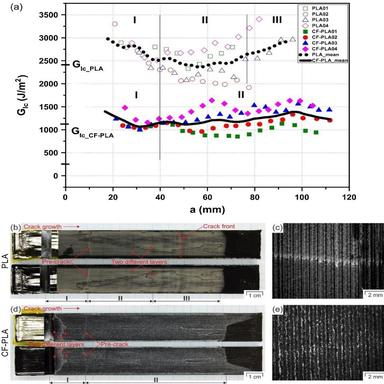
Crack resistance curves of tested DCB specimens of PLA and CF-PLA according to the modified beam theory (a) and fracture surfaces of the tested DCB specimens of PLA (b, c) and CF-PLA (d, e). To visualise the pre-crack, a representation of higher magnification is given in (c) for PLA and (e) for CF-PLA. In (b), the dashed line serves as a facilitation of the visibility of the crack front. In (b) and (d), the right dark spots represent the cryo-fracture for the separation of the two beams.